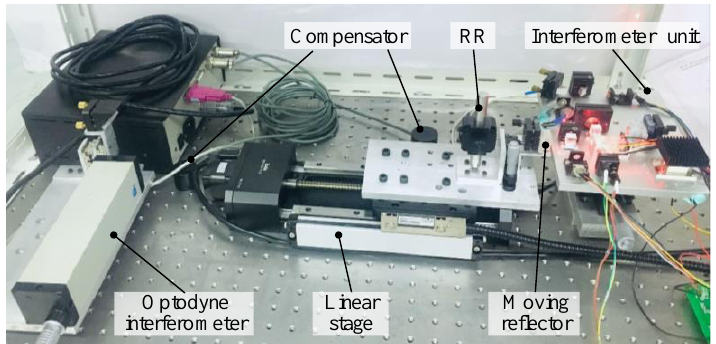
Figure 11. Experimental setup for distance measurement.